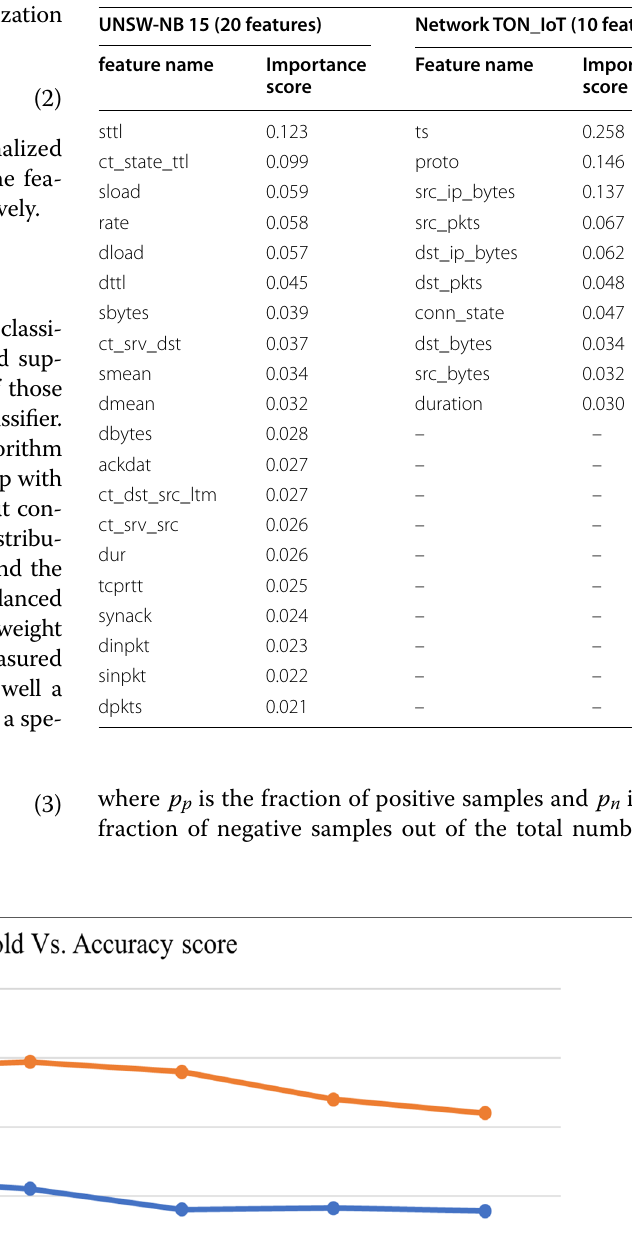
Table 4 Selected features of UNSW-NB 15 and Network TON_IoT